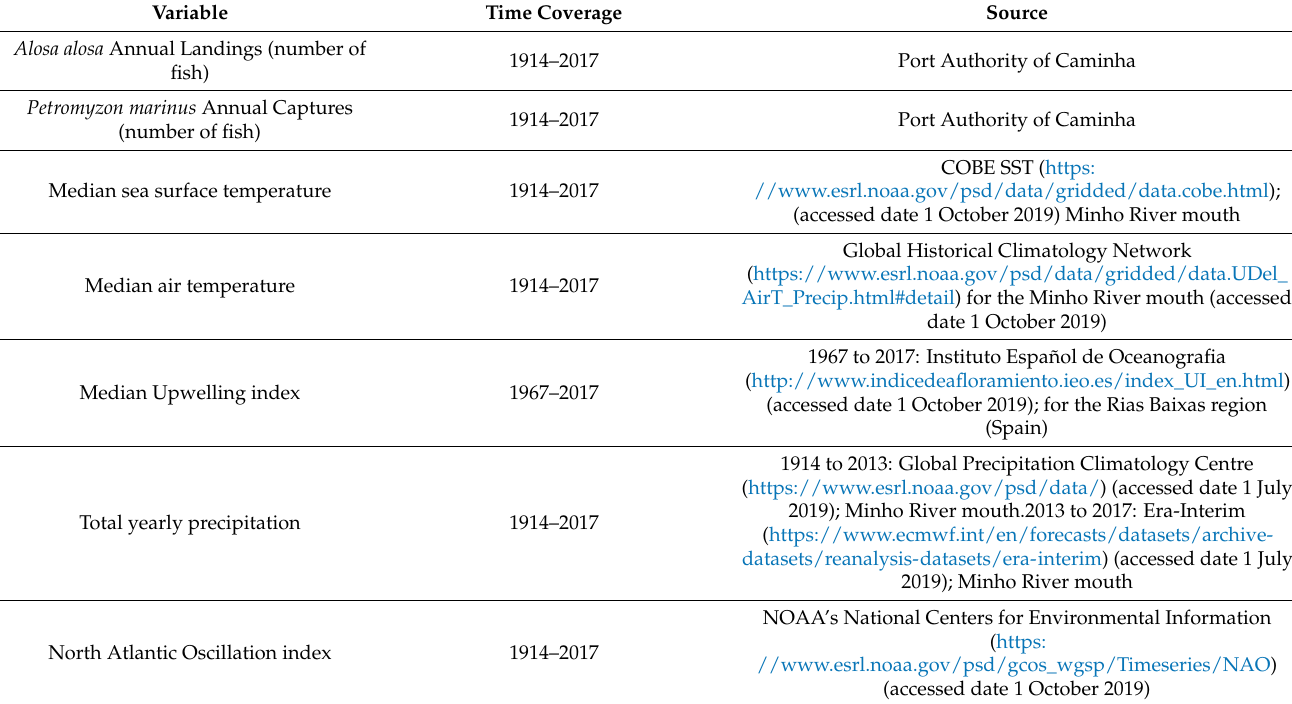
Table 1. Time coverage and source of all collected